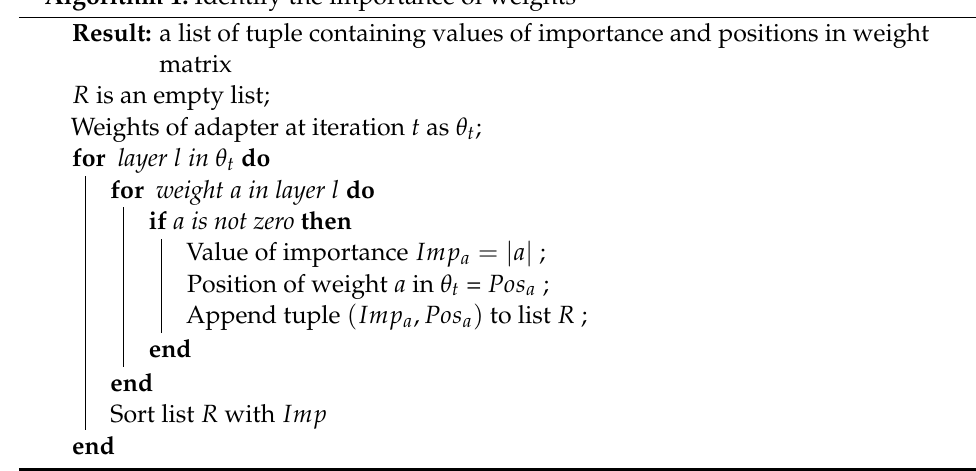
Algorithm 1: Identify the importance of